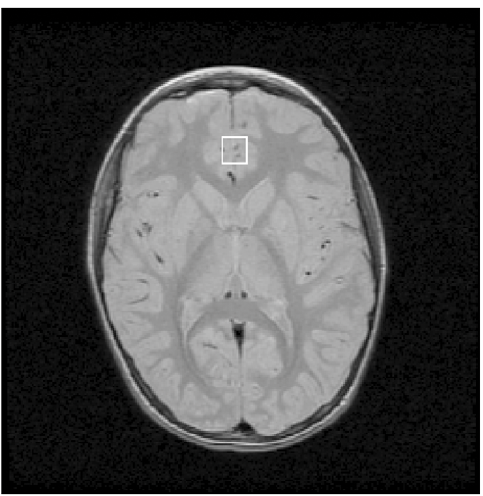
Figure 1. Axial-oblique spin-echo MRI of the brain at level of the basal ganglia showing position of midline pregenual anterior cingulate ( pACC ) proton magnetic resonance spec- troscopy voxel ( whitebox ) . Experiment 1.